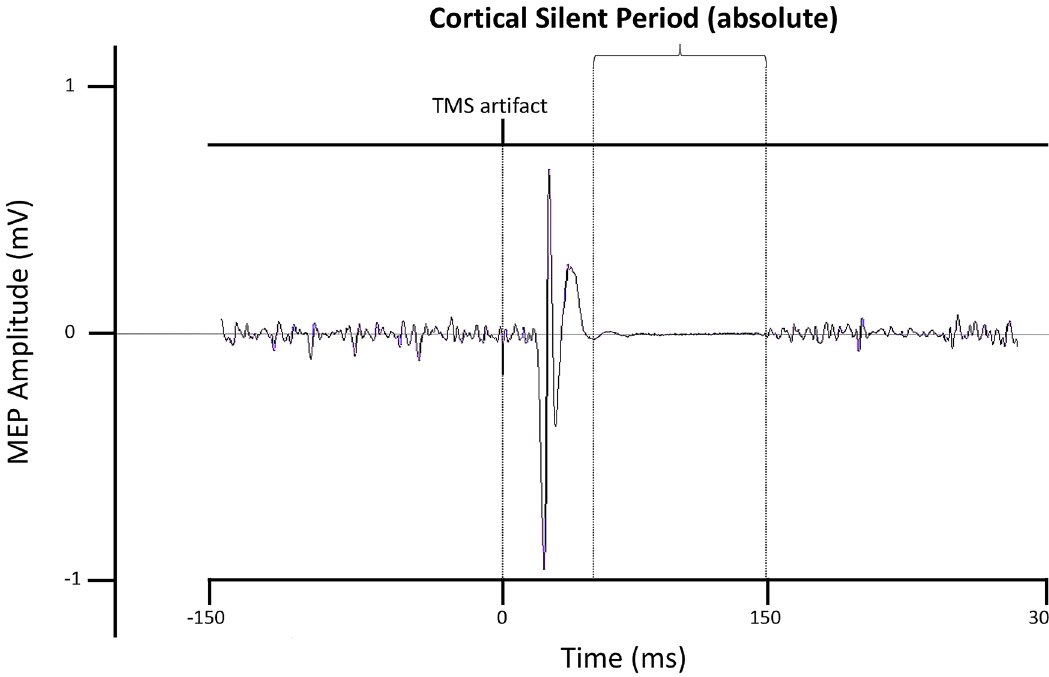
Figure 1. Representative traces of the FDI’s cortical silent period at 30% maximal voluntary contraction